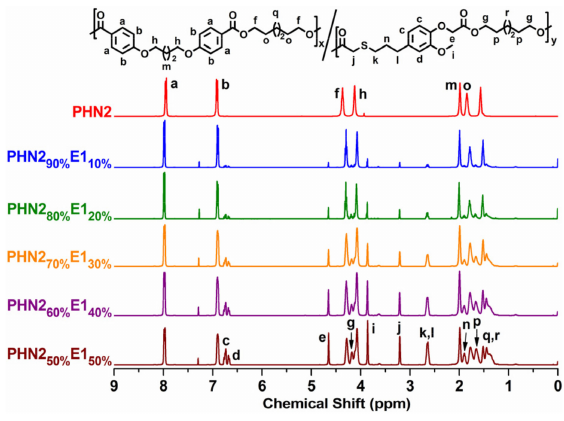
Figure 1. Compared 1 H NMR spectra of PHN2 1 − x E1 x .